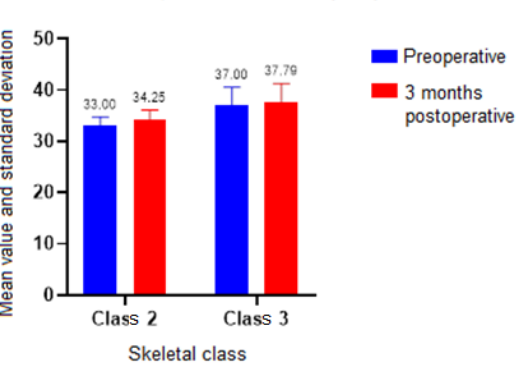
Figure 8. Nose width assessment.